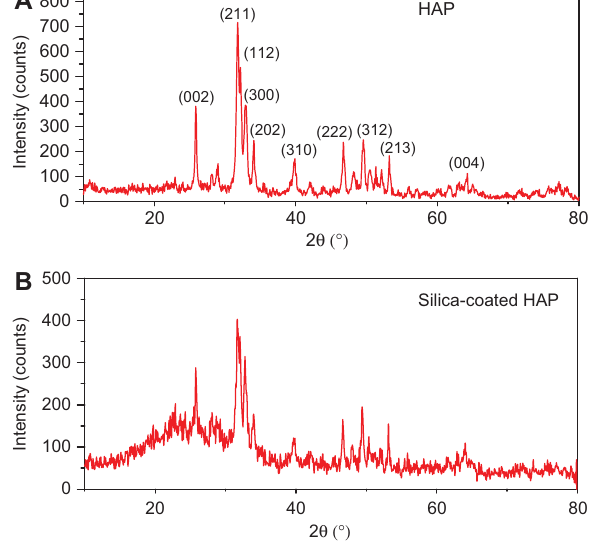
Figure 3 X-ray diffraction pattern of (A) hydroxyapatite particles (as synthesized) and (B) 50 wt % silica-coated HAP (HAPS